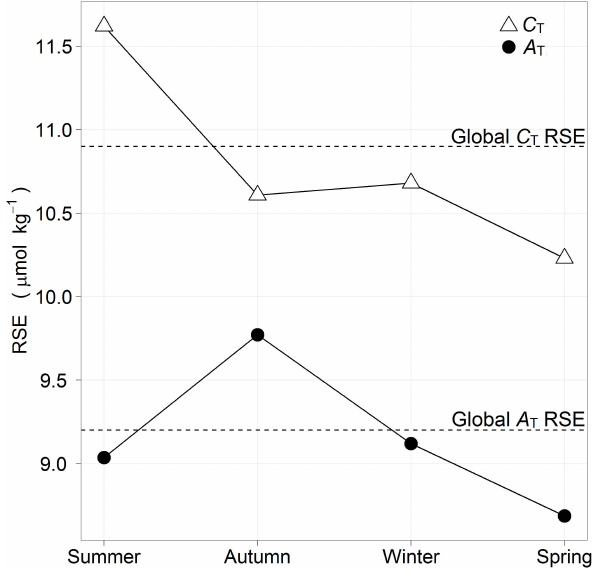
Fig. 14. SOMLO C T / A T seasonal independent test RSE values. Southern Hemisphere seasons are defined as summer (Dec–Feb), autumn (Mar–May), winter (Jun–Aug) and spring (Sept–Nov). Northern Hemisphere seasons differ by 6